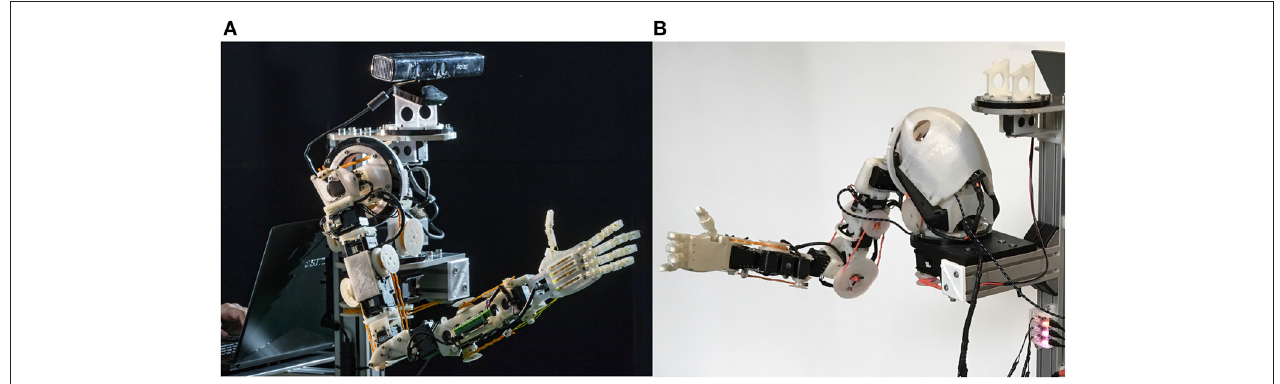
FIGURE 1 | The original GummiArm 7+1 DOF robot arm with variable-stiffness is shown in (A) . The CE/RE version is shown in (B) . The project is open source and the arm is mostly 3D-printable, leading to easy replication. The arm dimensions are scaled to a 50th percentile female human as defined in NASA (1995). For all printable parts and code see: https://github.com/GummiArmCE.